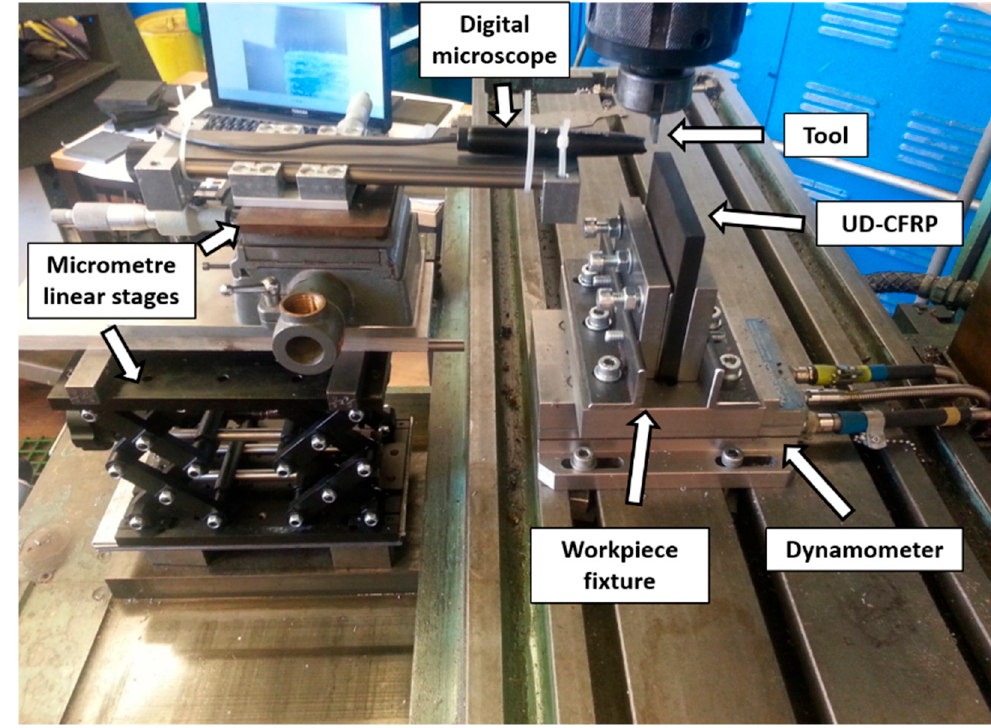
Figure 2. Experimental setup for unidirectional orthogonal cutting.